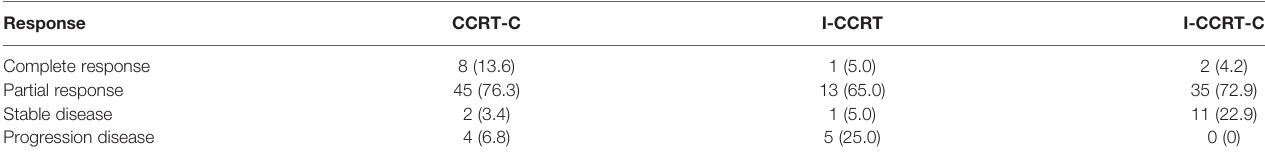
TABLE 2 | The treatment response rates among groups [ n (%)]. Response Complete response